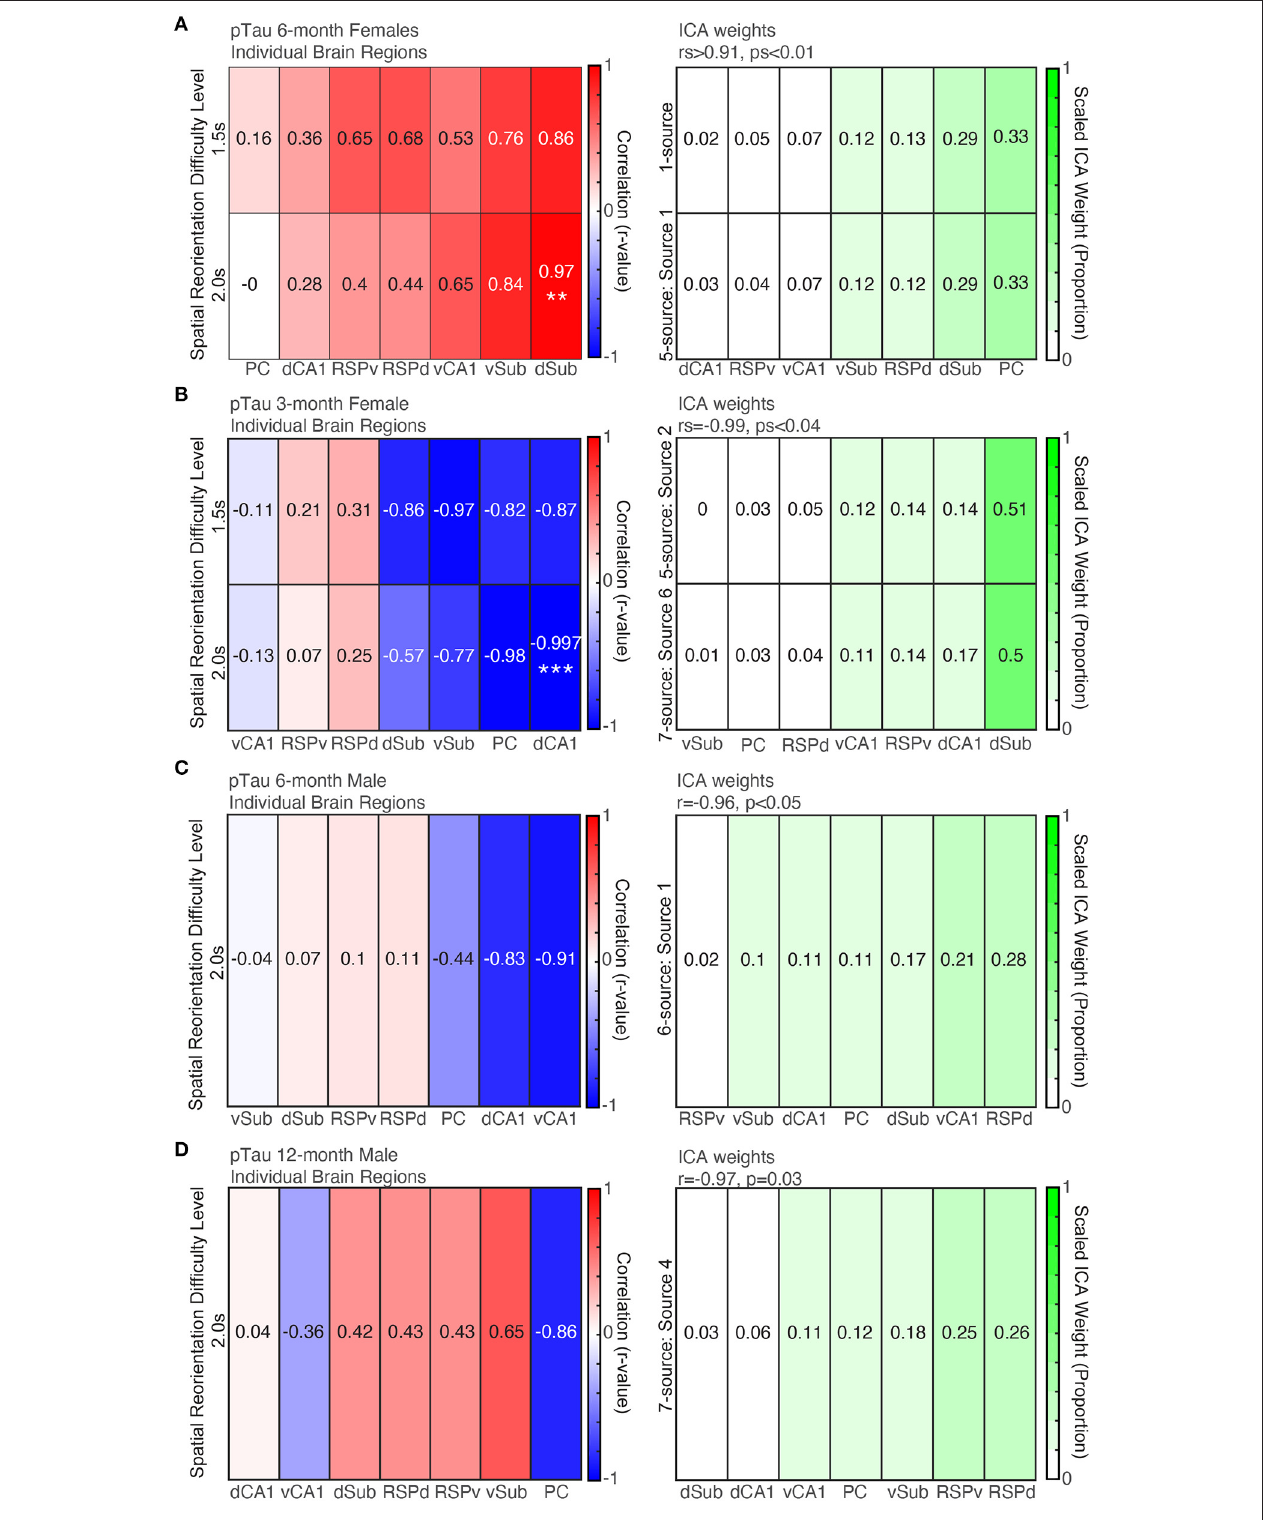
FIGURE 7 | More pTau pathology is predictive of spatial reorientation performance, but only for 6-month female mice. Left . Correlations between pTau raw density for individual brain regions and spatial reorientation performance for the 1.5 and 2.0s difficulty levels for 6-month female ( A ) and male ( B ) mice, 3-month female mice ( C ), and 12-month male mice ( D ). Right . Brain region weights (expressed as a proportion) identified by Independent Components Analysis (ICA) for the linear combination that was significantly correlated with spatial reorientation performance for the 1.5 and 2.0s difficulty levels for 6-month female ( A ) and male ( B ) mice, 3-month female mice ( C ), and 12-month male mice ( D ). ** p < 0.01, *** p <